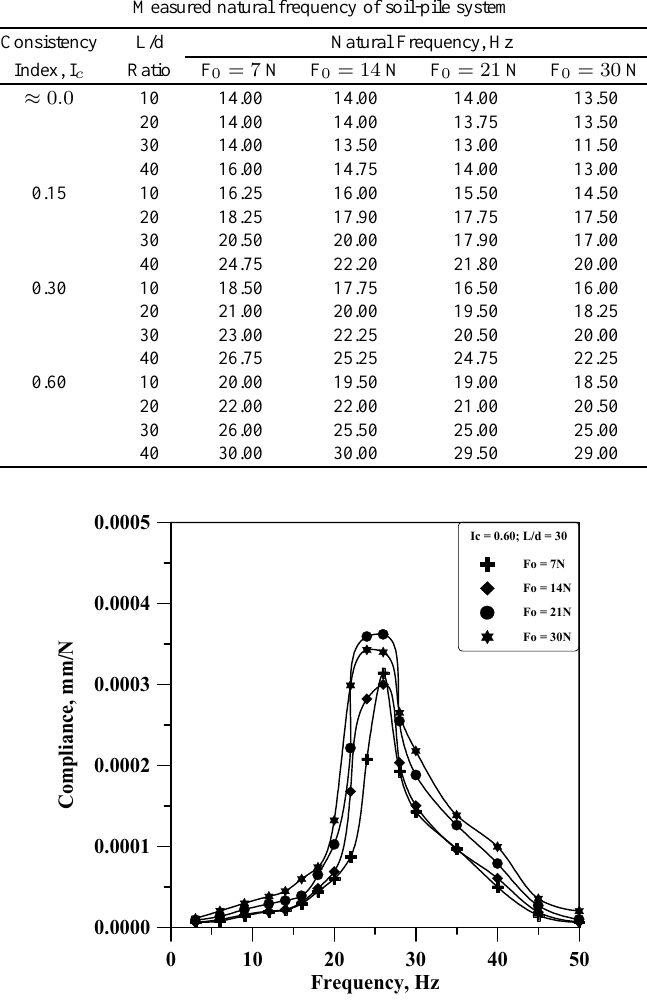
Fig. 8. Normalized frequency response curve for I c = 0.60; L/d =